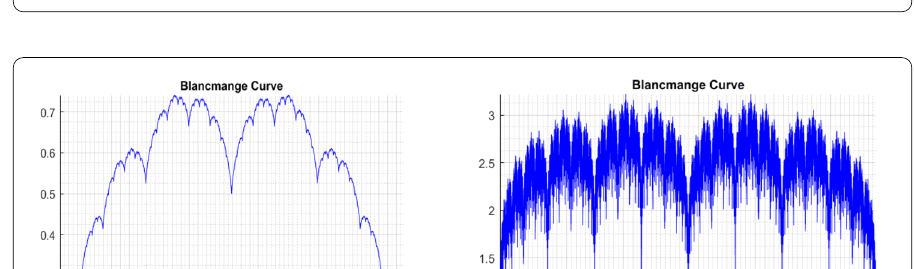
Figure 20 Blancmange function c = 3.7